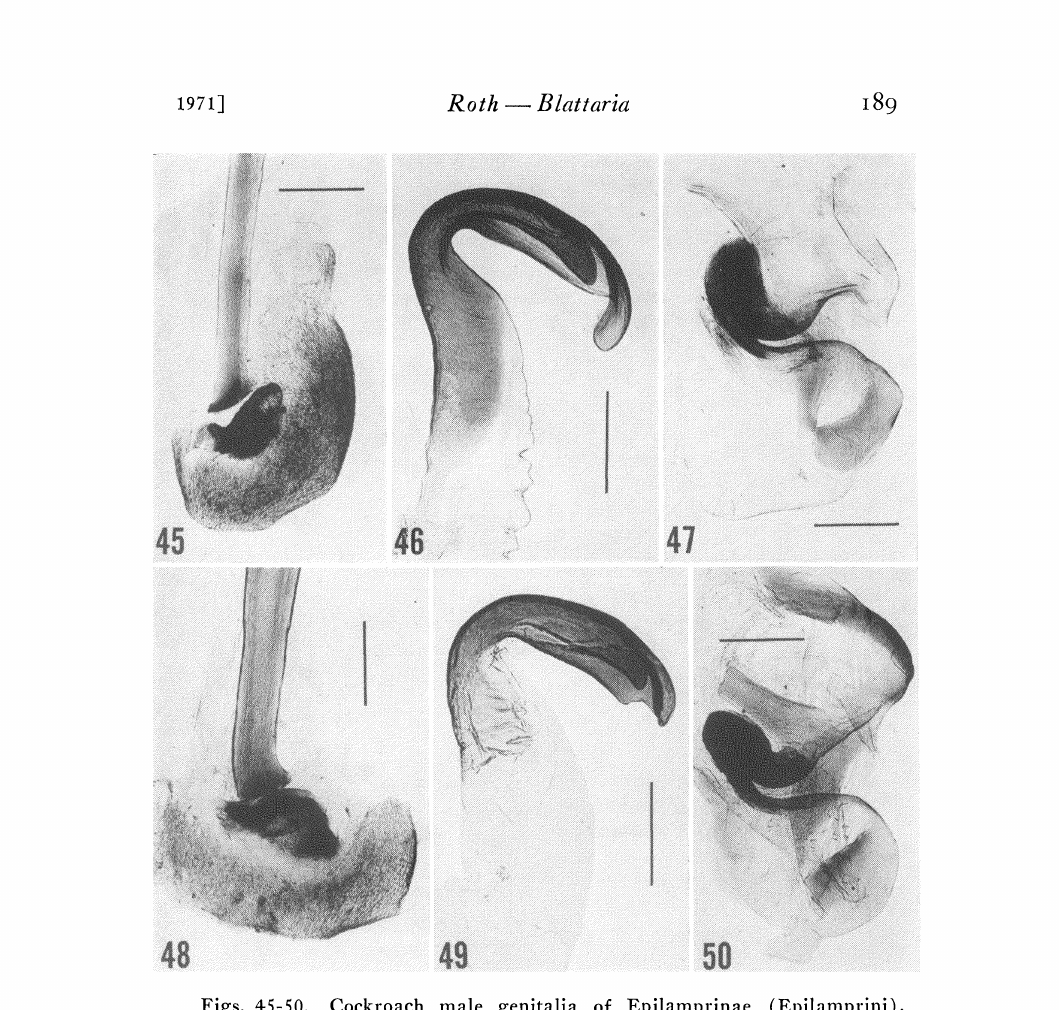
Figs. 45-50. Cockroach male genitalia of Epilamprinae (Epilamprini). 45-47. (119 ANSP). Li,topeltis oreas. Paratype. (from specimen shown in Fig. 7). 48-50. (114 ANSP). Cariacasia capucina. Type. (from specimen shown in Fig. 8). (scale 0.3